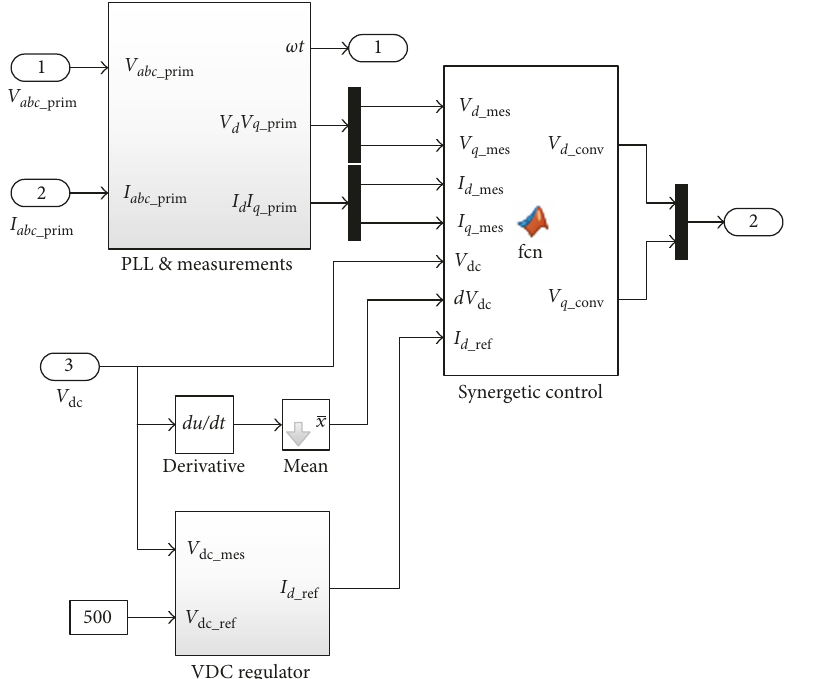
Figure 6: VSC main